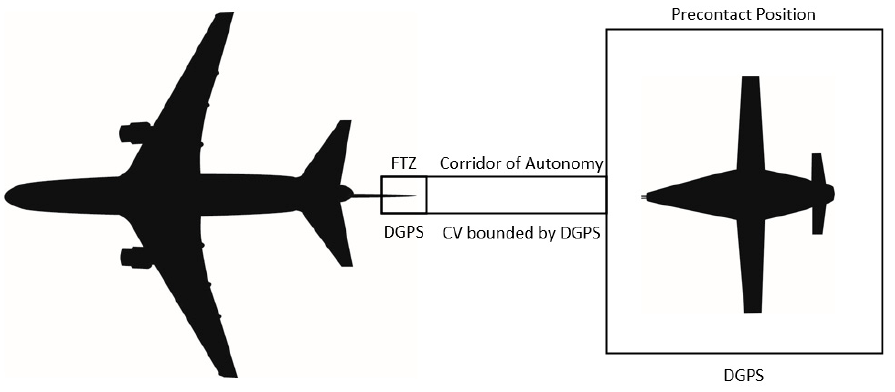
Figure 12. Transition of sensors from Astern to FTZ.